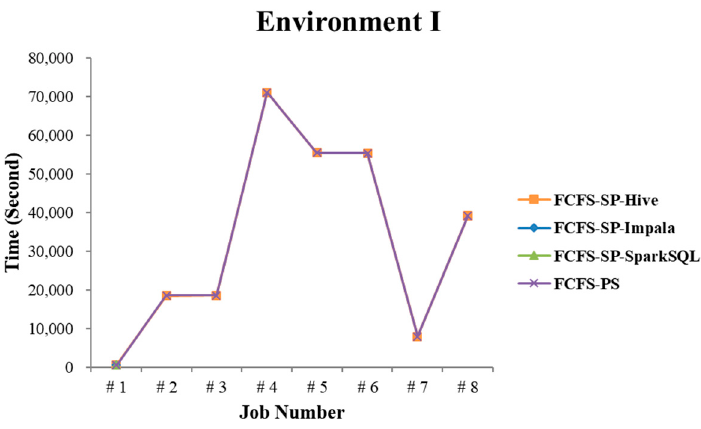
Figure 30. Execution time of each use case in test environment I.